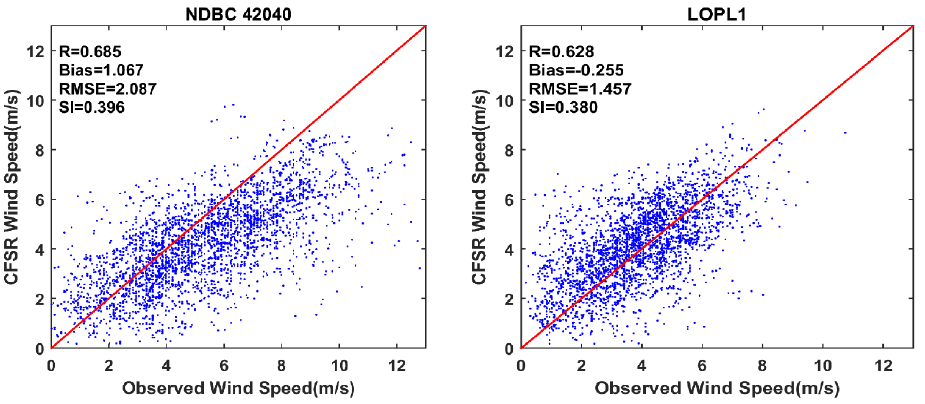
Figure 14. Evaluation of CFSR wind speed at NDBC 42040 and LOPL1.